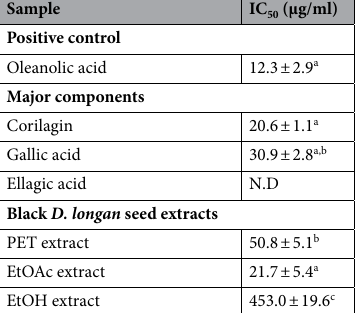
Table 1. Half-maximal MMP-1 inhibitory concentration (IC 50 ) of black D. longan seed extracts. N.D ., Not detected; PET extract, black D. longan seed petroleum ether extract; EtOAc extract, black D. longan seed ethyl acetate extract; EtOH extract, black D. longan seed ethanolic